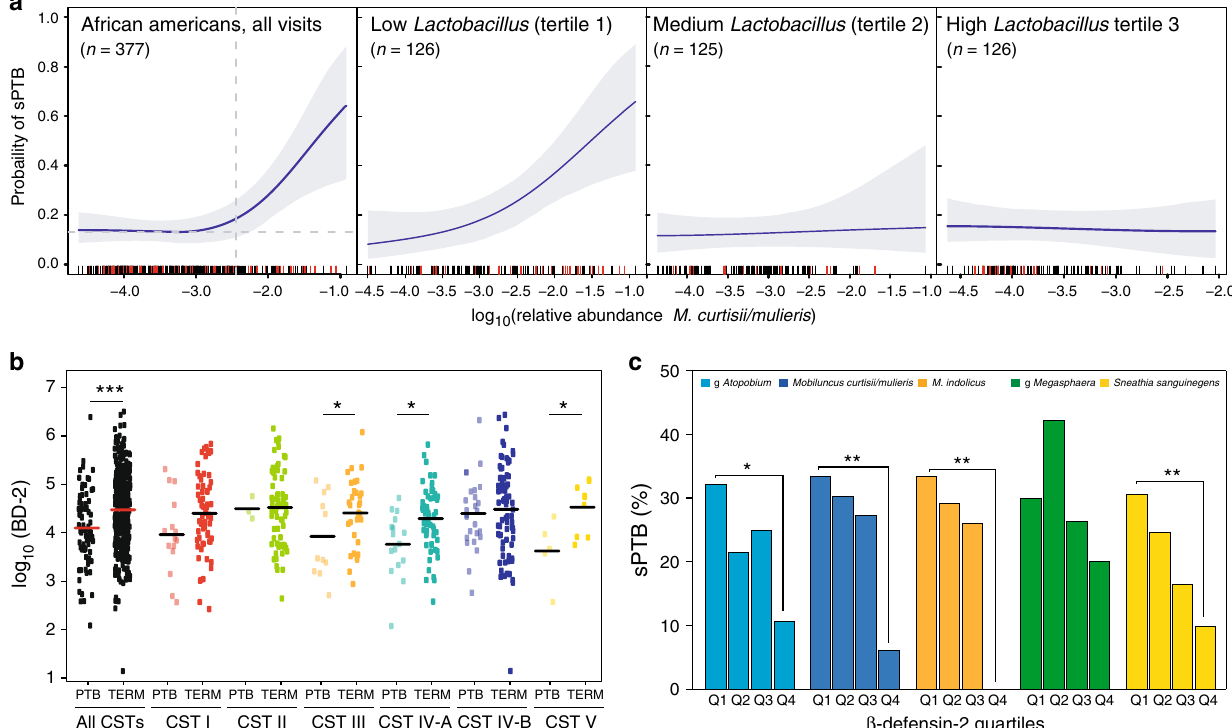
Fig. 2 β -defensin-2 and microbiota modulate the risk of spontaneous preterm delivery. a Modulation of the risk of sPTB by relative abundance of M. curtisii/ mulieris strati fi ed by Lactobacillus spp. relative abundance tertiles within AA when all visits are considered. n represents the number of samples where M. curtisii/mulieris was detected. b log 10 β -defensin-2 abundances at visit 1 in AA women strati fi ed by pregnancy outcomes and vaginal community state types. p -values estimated using a t -test. c At visit 1 in AA women, the risk of sPTB associated with the relative abundance of fi ve bacterial taxa is modulated by the abundance of β -defensin-2. p -values were estimated using a Bayesian 2-proportions binomial model with uniform prior implemented in rstan R package. Statistical signi fi cance is shown as * p -value < 0.01, ** p -value < 0.001 and *** p -value <